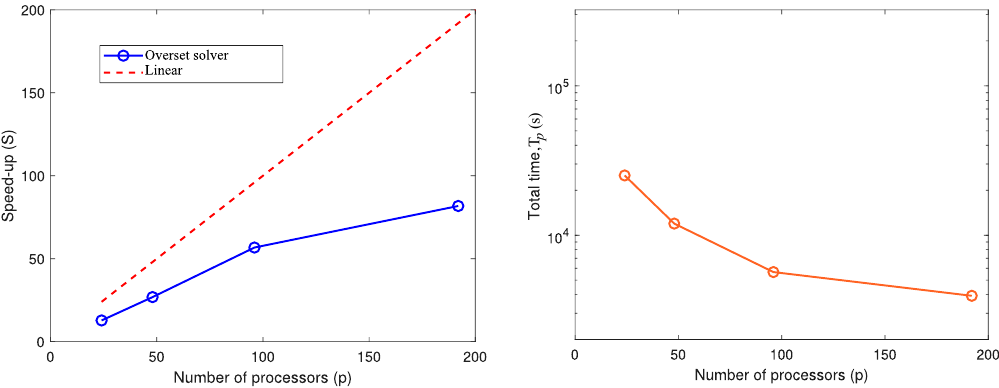
Figure 15. Variation of Speed-up (S) and total execution time (Tp) for simulation (in seconds), with increase in number of processors ( p